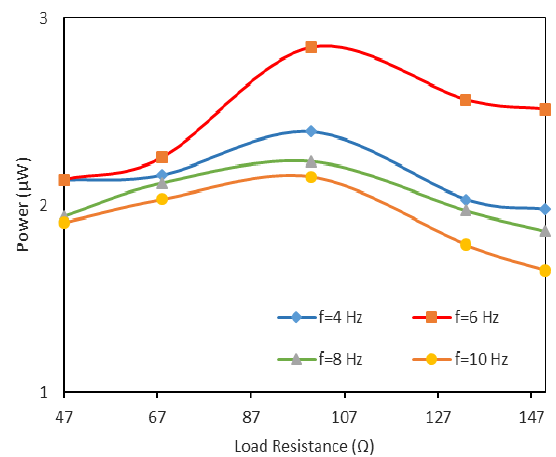
Figure 6. Variation of effective power with load resistance in different modes.